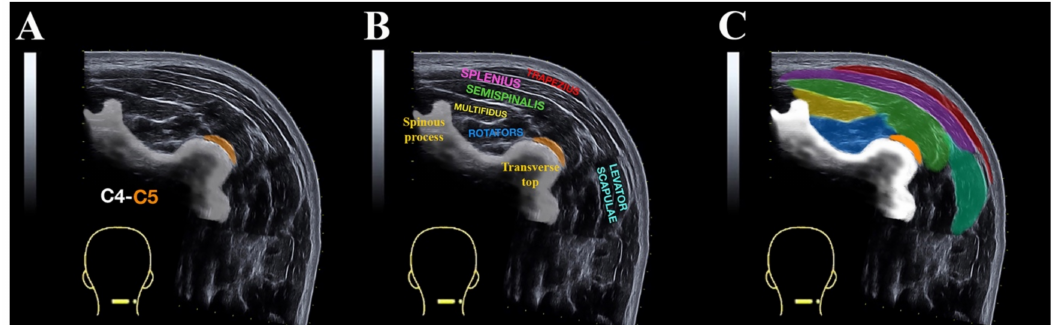
Figure 1. Panoramic ultrasound imaging at C4 to C5 level showing the superficial posterior neck muscles. ( A ) Image without labelling; ( B ) image with muscular names labelled; ( C ) the cross sectional area (CSA) assessment of the upper trapezius (red), splenius layer (pink), semispinalis layer (green), multifidi (yellow), rotator (blue), and levator scapulae (light green). The CSA of each posterior cervical muscle layer, i.e., upper trapezius, splenius, semispinalis,